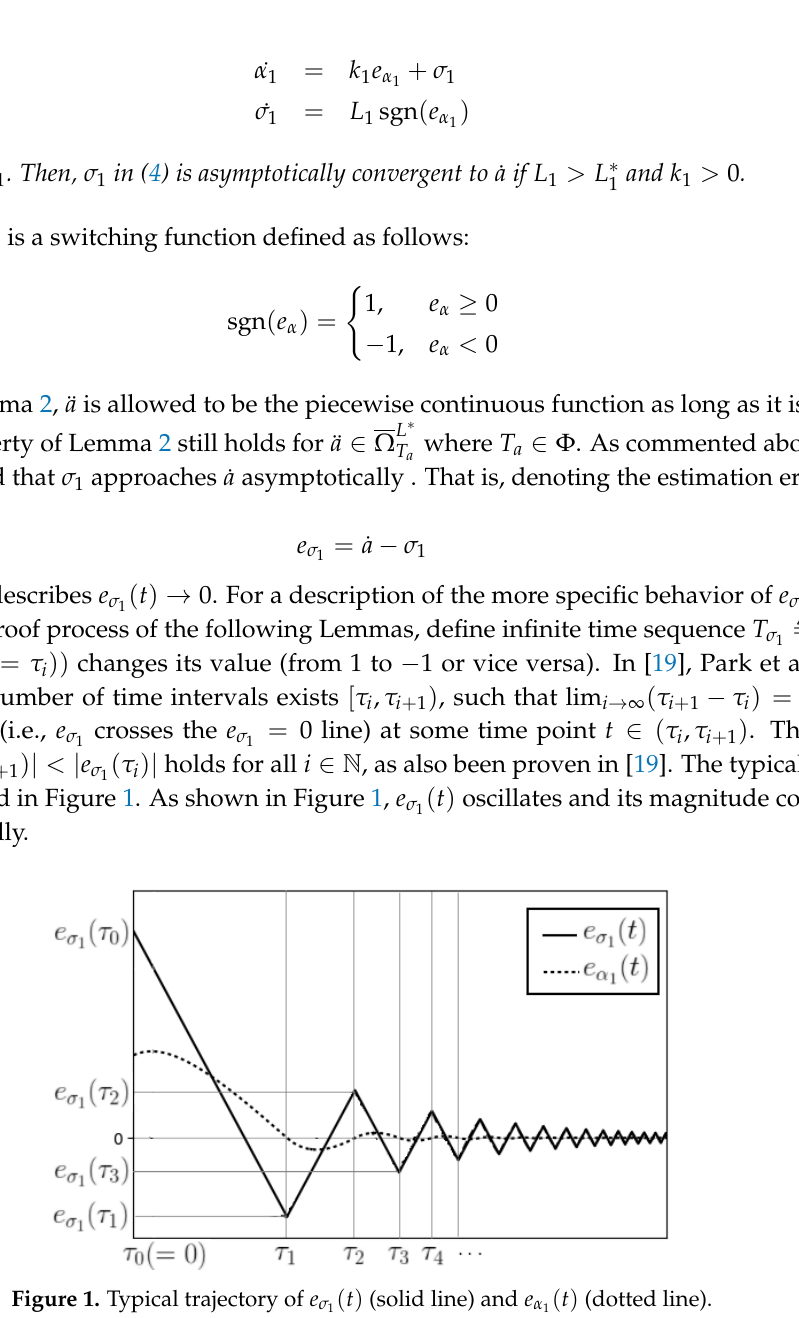
Figure 1. Typical trajectory of e σ